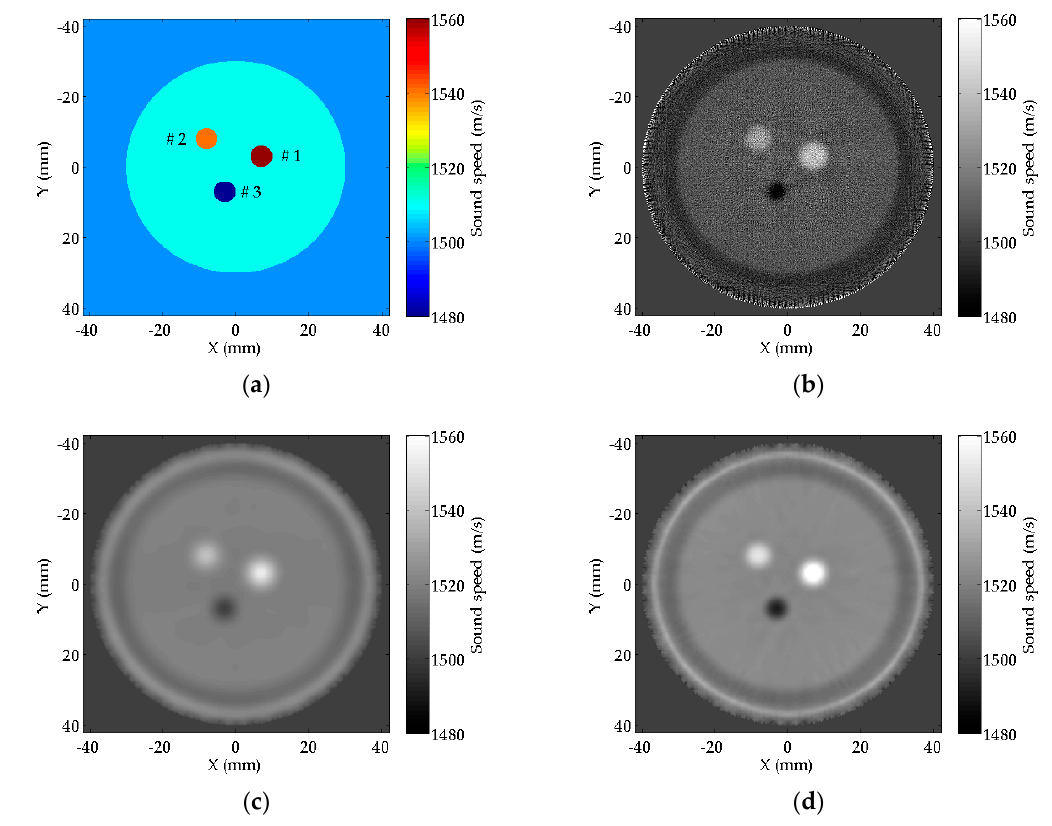
Figure 6. ( a ) The designed numerical breast phantom model; ( b ) reconstructed sound speed (SS) image of the numerical breast phantom by raypath travel-time tomography (RTT); ( c ) reconstructed SS image of the numerical breast phantom by FZTT; ( d ) reconstructed SS image of the numerical breast phantom by ZSFZTT. Table 1. The design of the numerical breast phantom.